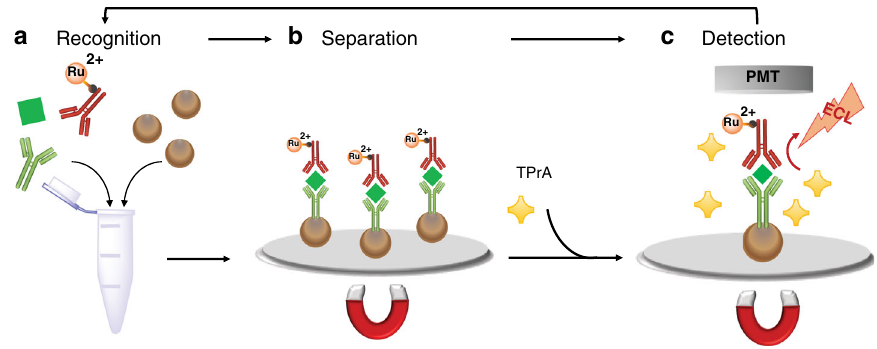
Fig. 5 Schematic representation of the commercial electrochemiluminescence (ECL) immunoassay (sandwich assay). a Recognition: a speci fi c antigen (green square) is mixed together with an antigen-speci fi c biotinylated monoclonal antibody (in green) and an antigen-speci fi c monoclonal antibody labeled with tris(2,2 ′ -bipyridine)ruthenium(II) (Ru 2 + in red) to form a sandwich complex which bind to streptavidin-coated microparticles (brown spheres); b separation: microparticles are magnetically captured onto the surface of the electrode and unspeci fi c substances are removed; c detection: a voltage is applied to the electrode inducing ECL emission, which is measured by a photomultiplier tube (PMT). TPrA: tri-